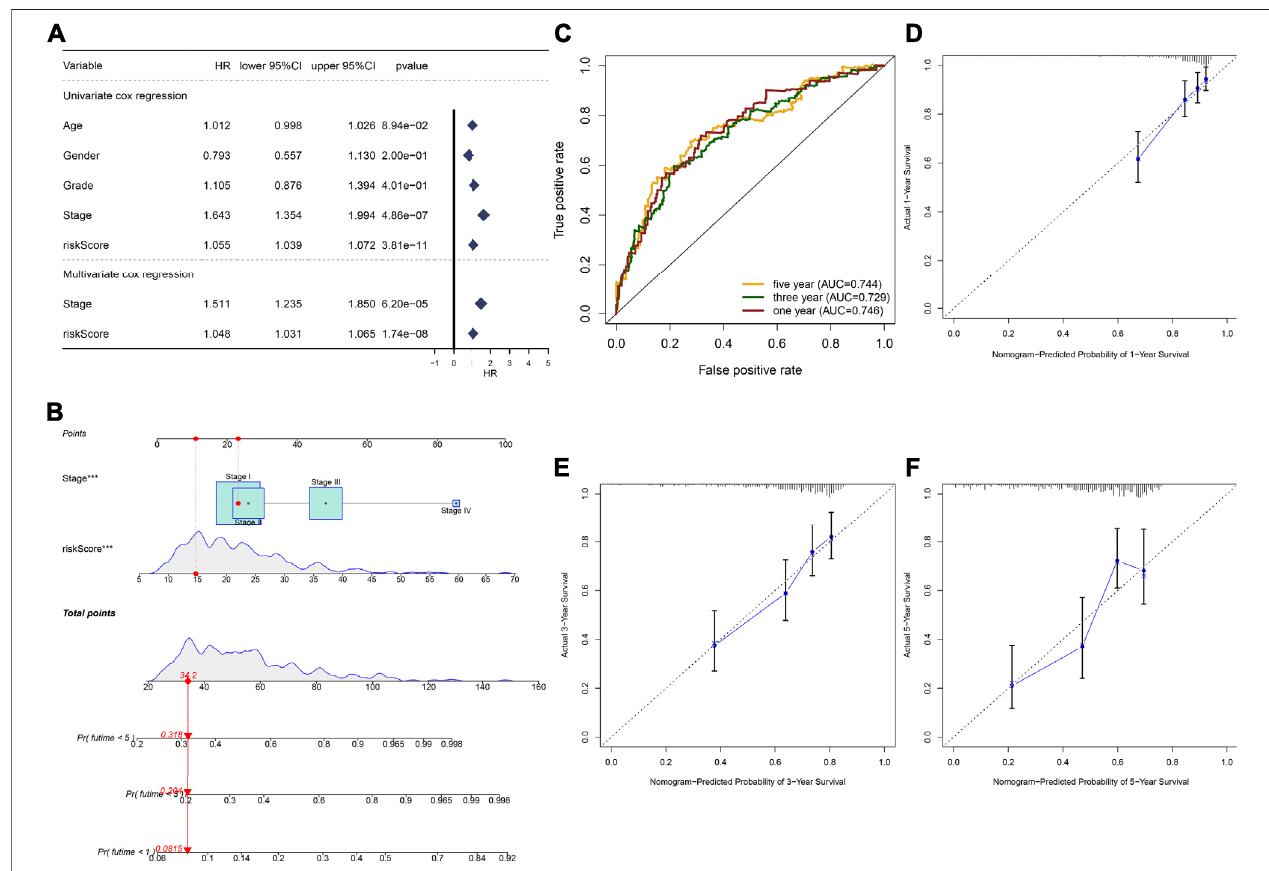
FIGURE 3 | Establishment of a nomogram by incorporating stage and TLR-based RS for HCC prognosis in the TCGA cohort. (A) Uni- and multivariate Cox regression analyses of the associations between survival outcomes and age, gender, grade, stage, and TLR RS of HCC patients. (B) Constructing a prognostic nomogram that included stage and TLR RS for prediction of one-, three-, and 5-year OS probabilities. (C) ROC curves under one-, three-, and 5-year OS for HCC subjects based on the nomogram model. (D – F) Calibration curves of this model-estimated and observed one-, three-, and 5-year OS probabilities.